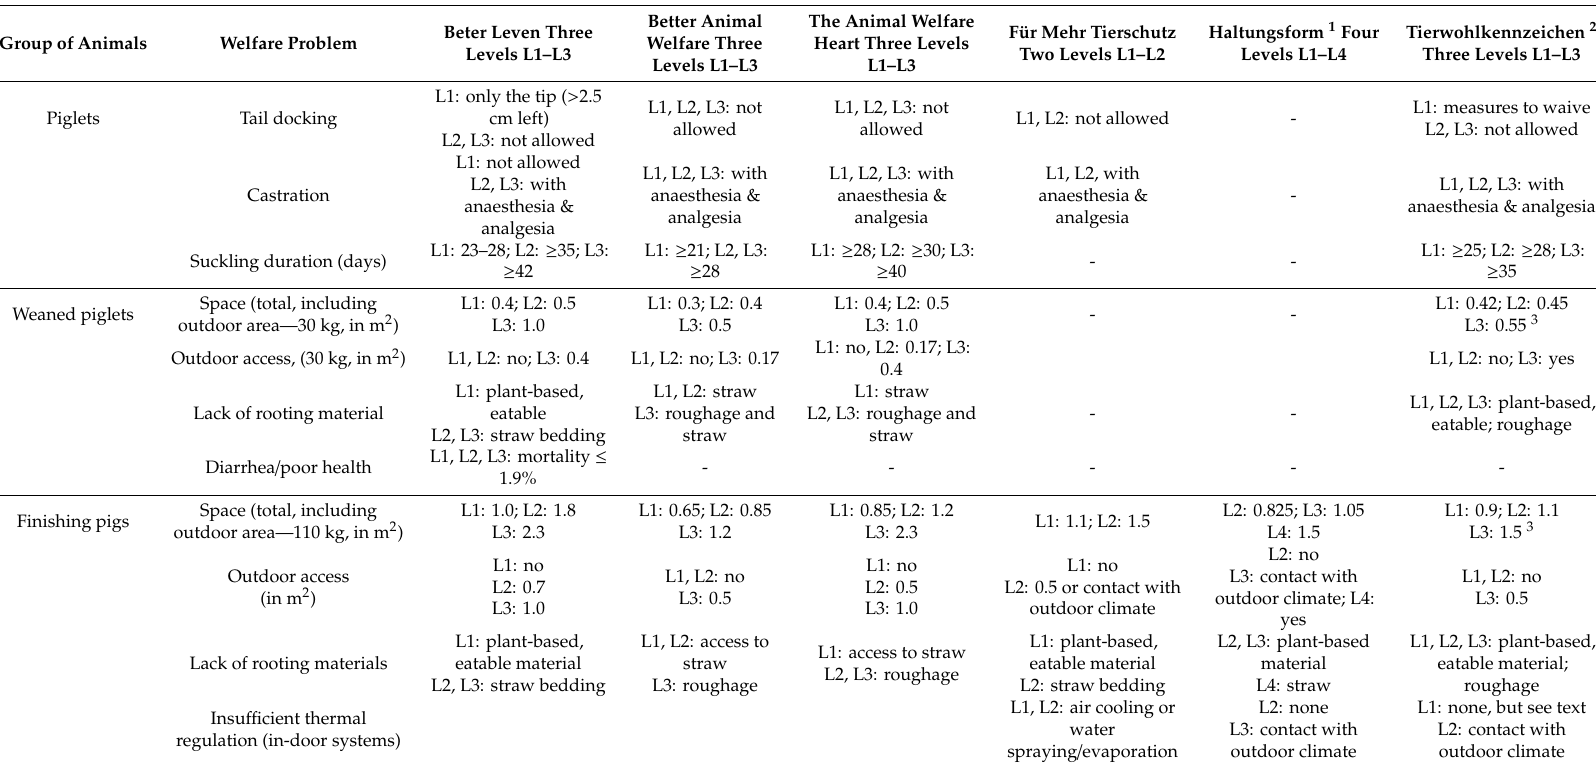
Table 2. An overview showing how labels address the major welfare problems in pig production for growing pigs. The labels comprise between 2 and 4 levels (L), with higher levels indicative of higher